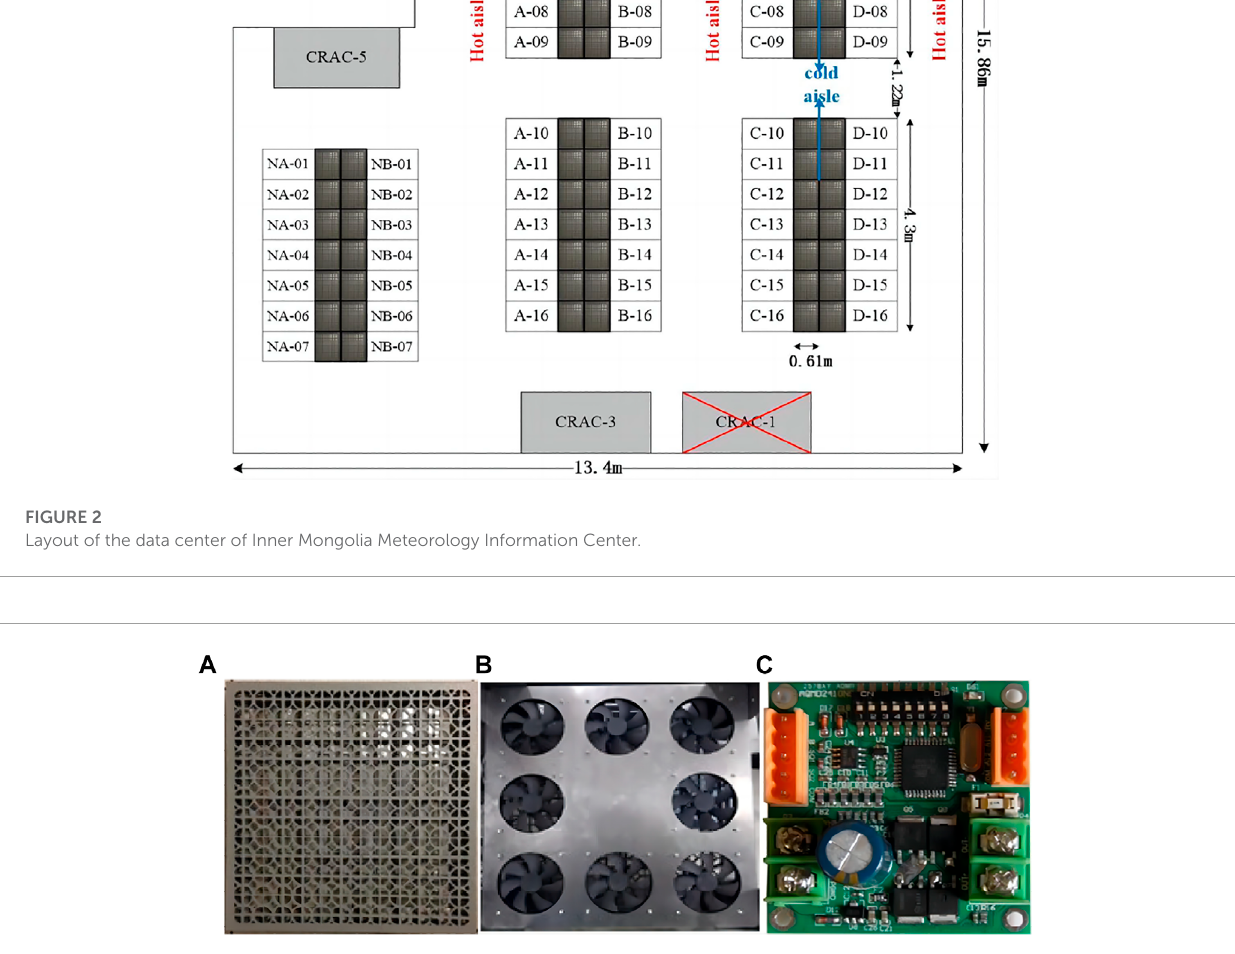
FIGURE 3 The prototype of active tile: (A) Front view, (B) back view, (C) fan speed